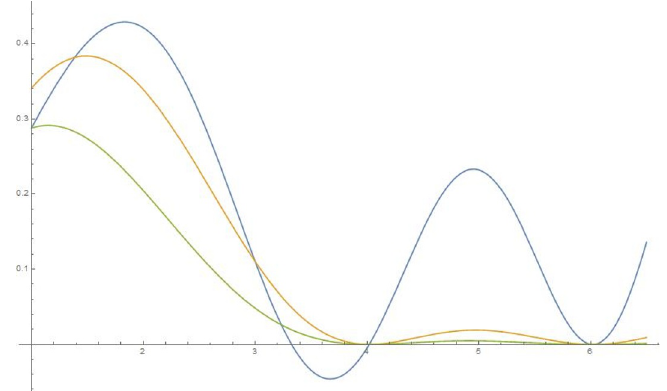
Figure 1 . Plot of γ = γ anal. + γ n.-a. for d = 3 , ∆ = 2 and varying τ along the x axis. 0 ,‘ 0 | τ, 0 0 ,‘ 0 | τ, 1 0 ,‘ 0 | τ, 0 In blue we have ‘ 0 = 0 , in orange ‘ 0 = 1 and in green ‘ 0 = 2 . We see that for ‘ > 0 , where